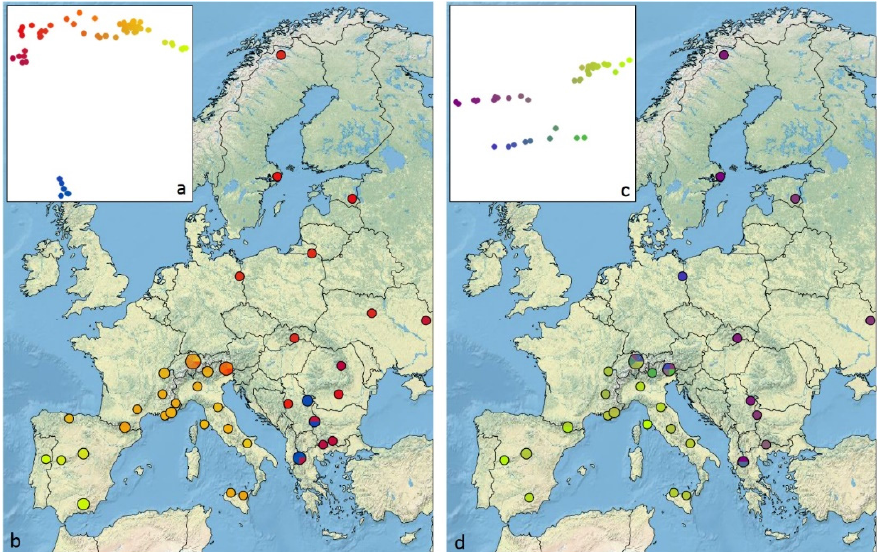
Figure 1. Patterns of genetic and morphological differentiation in M. athalia and M. celadussa : ( a ) The configuration obtained after PCoA of Edwards’ distances calculated on ddRAD data and projected in RGB space where similar individuals are characterised by similar colours; ( b ) The geographic location of each specimen with the colour obtained in the PCoA; ( c ) The configuration obtained after PCA on genitalia traits; ( d ) The geographic location of specimens.